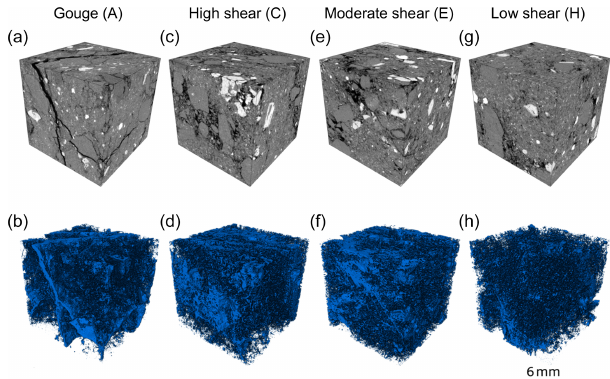
Figure 4. Tomographic reconstructions of four samples across the shear zones: (a–b) A, (c–d) C, (e–f) E, (g–h) H. The upper row shows density-based images of tomographic reconstructions, whereas the lower row highlights the porous network in blue, and the solid fraction is transparent. The reconstructions show that the porous fraction becomes increasingly localised towards the fault plane (i.e. from right to